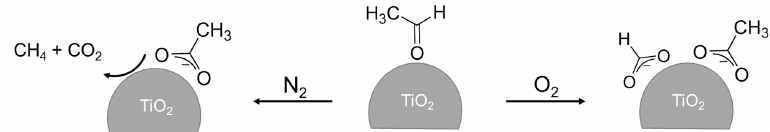
Figure 10. Schematic illustration of the different intermediates formed from acetaldehyde on the anatase surface, and in the gas phase in the O 2 and the N 2 atmosphere, observed by ATR-FTIR and MS.